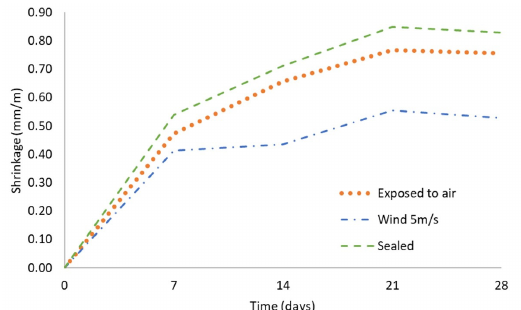
Figure 15. 1:3 mixture’s long-term average shrinkage at different air exposures.